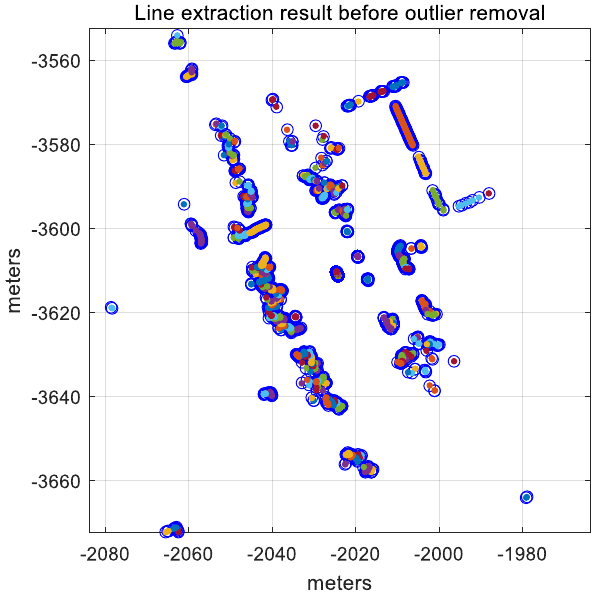
Figure 11. Line extraction result using the IEPF algorithm.